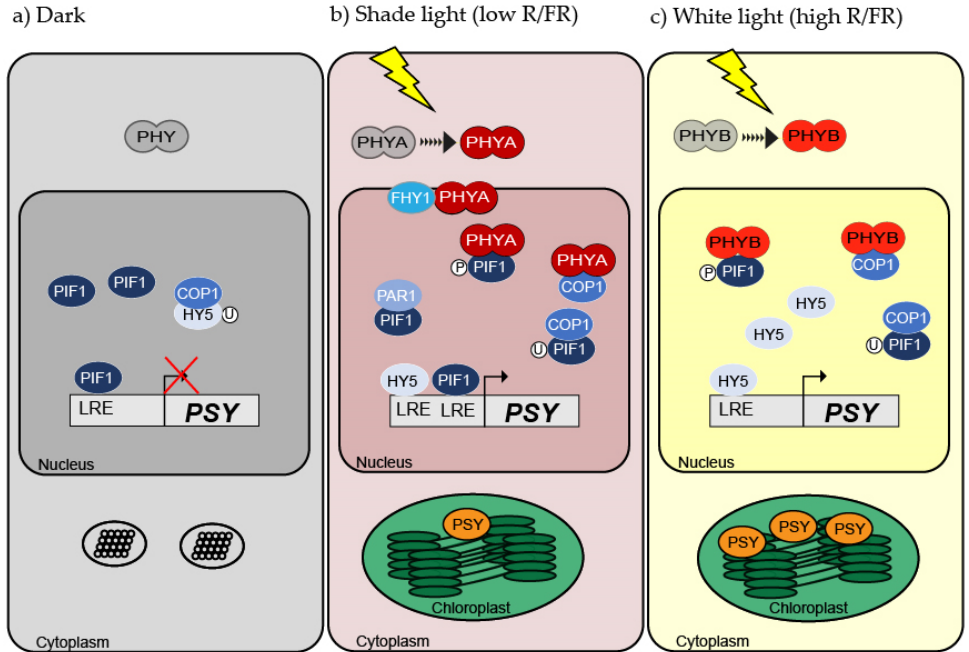
Figure 2. Regulation in carotenoid synthesis in photosynthetic organs under different light conditions. ( a ) Plants grown in dark develop etioplasts were the expression of PSY and the synthesis of carotenoids is repressed by phytochrome interacting factors (PIFs) transcription factors. ( b ) Plants grown in shade exhibit a reduced expression of PSY and carotenoid synthesis in chloroplasts that take place due to the activation of phytochrome A (PHYA). ( c ) In the presence of white (W) light, a high level of PSY expression and carotenoid synthesis is observed due to phytochrome B (PHYB) activation. See further details in the